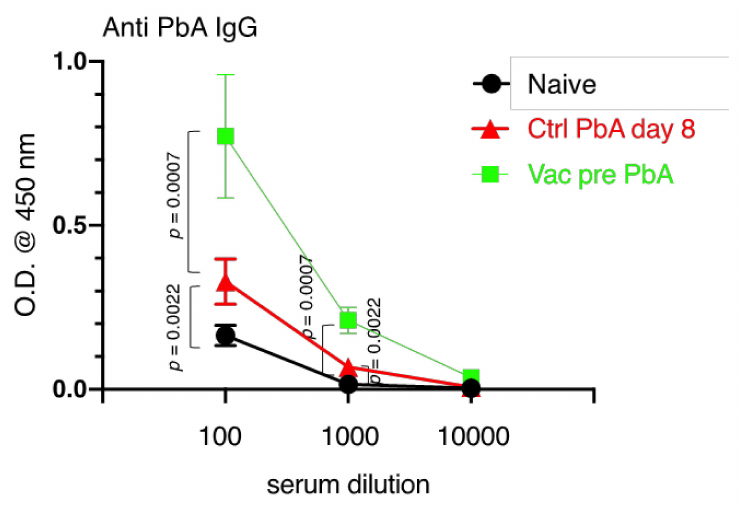
Figure 5. Plasmodium yoelii 17XNL live vaccination (Vac) induced cross-reactive antibody production against P. berghei ANKA (PbA). Serum samples collected from naive mice (N = 6; black circle), control (Ctrl) mice infected with PbA on day 8 (N = 6; red triangle), Vac mice pre-infected with PbA at 40 days after vaccination with Plasmodium yoelii 17XNL (N = 8; green square) were diluted 100-, 1000-, 10,000-fold, and PbA antigen-specific IgG was detected by ELISA. The optical density (O.D.) at 450 nm is shown. Data represent the mean ± standard deviation (SD). p values were determined by two-tailed Student’s t -test. A representative dataset is shown from 3 independent